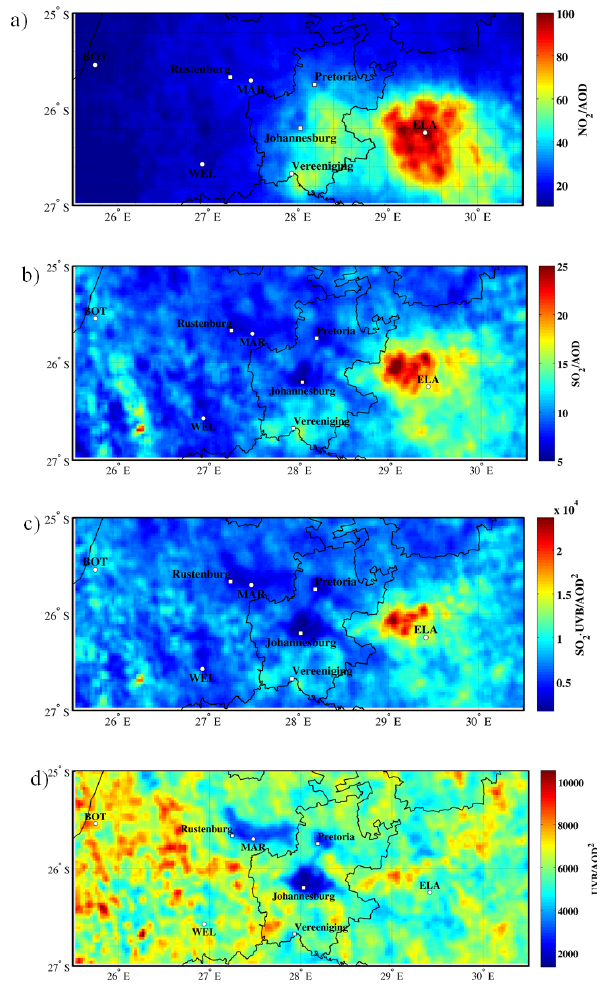
Figure 11. Spatial pattern of proxy medians for 2007–2010 calculated using satellite data. The proxies are (a) NO 2 /AOD, (b) SO 2 /AOD, (c) SO 2 · UVB/AOD 2 , and (d) UVB/AOD 2